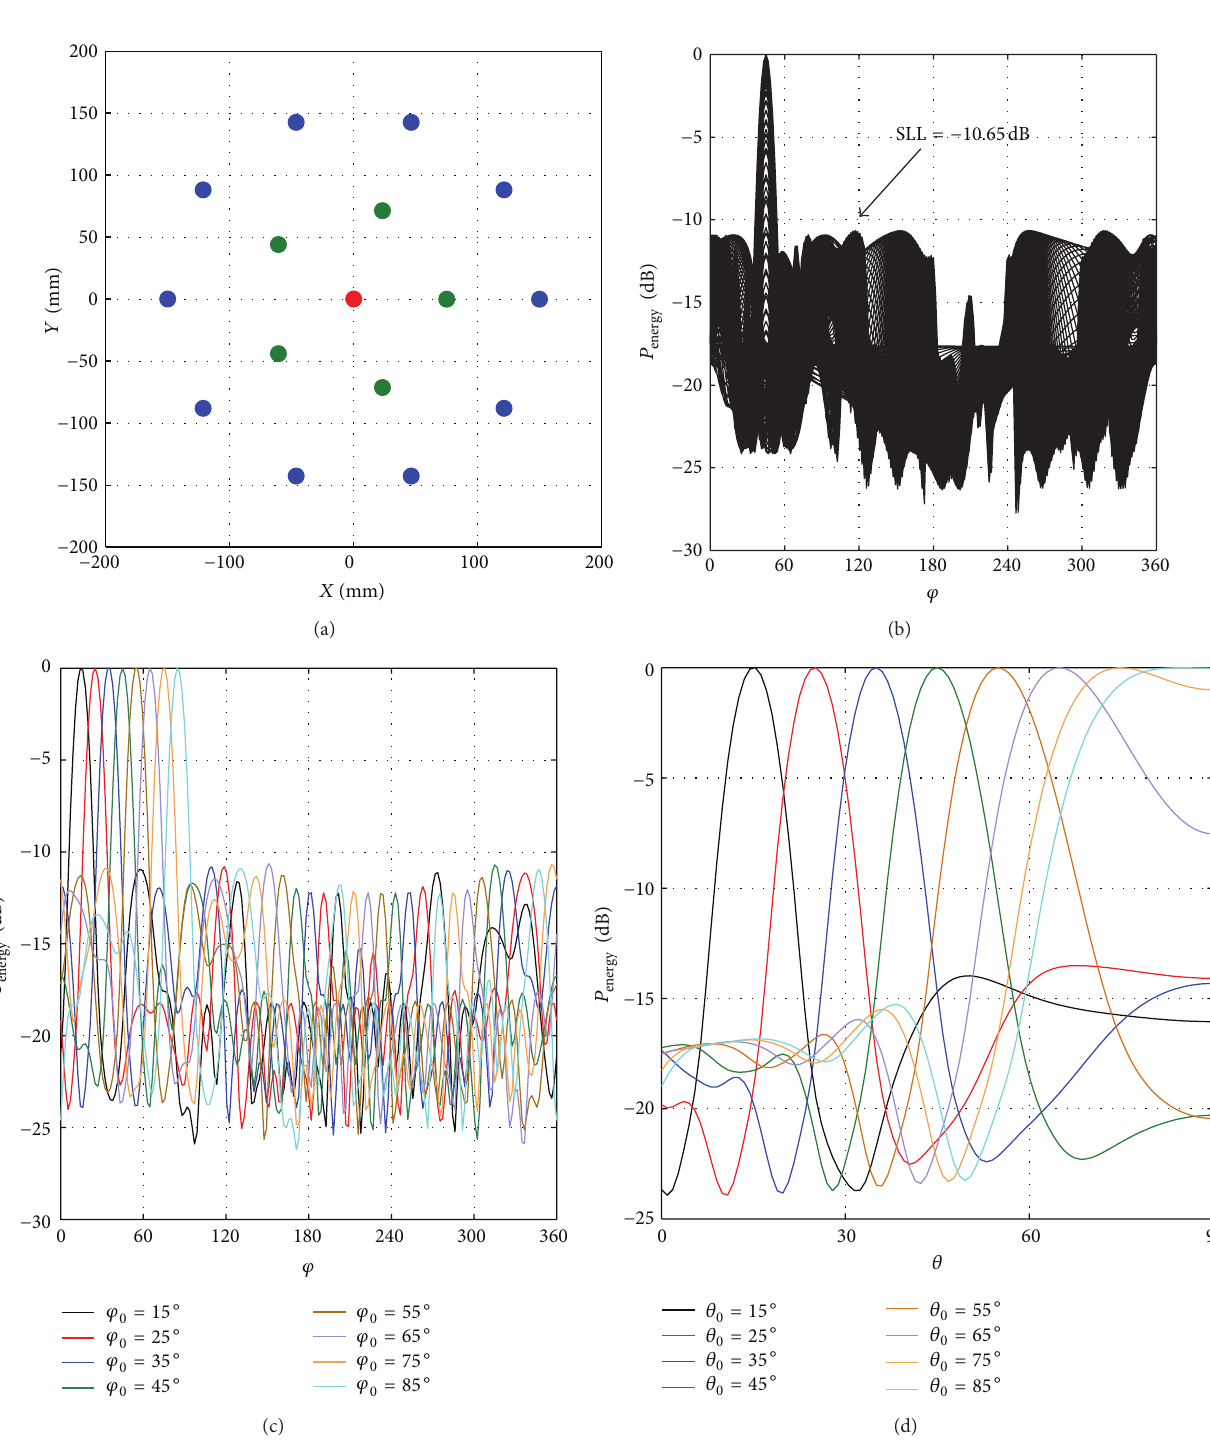
Figure 4: Result of UCRA: (a) antenna and delay distributions, (b) SEP in 𝜃 0 = 𝜑 0 = 45 ∘ , (c) azimuth cuts with 𝜃 0 = 45 ∘ , and (d) elevation cuts with 𝜑 0 = 45 ∘